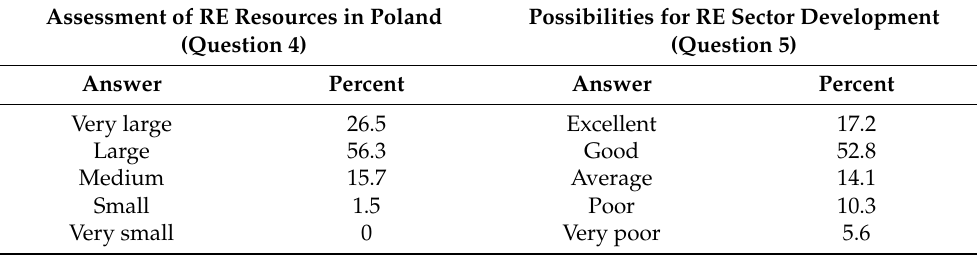
Table 4. Resource assessment and possibilities for RE sector development RE sector in Poland. Assessment of RE Resources in Poland Possibilities for RE Sector (Question 4)